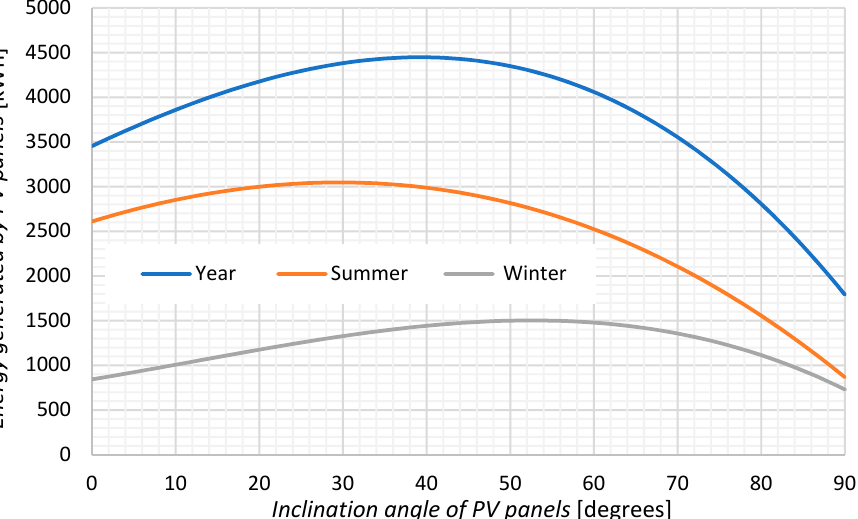
Figure 6. Influence of the slope angle of the collectors on the amount of produced energy depending on the season.